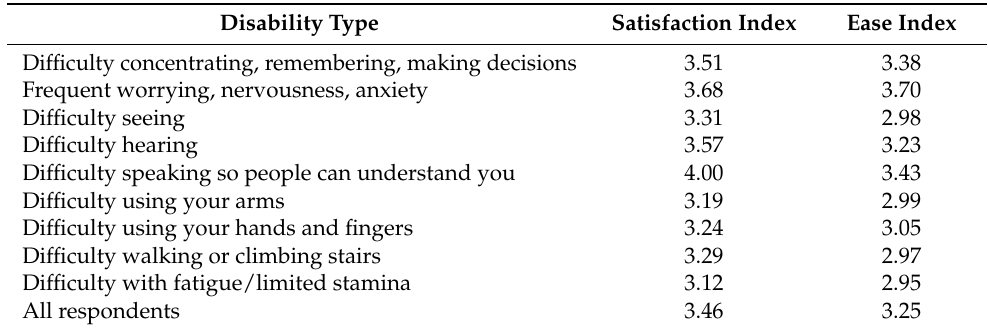
Table 4. Satisfaction with mHealth apps and ease of finding mHealth apps that work for